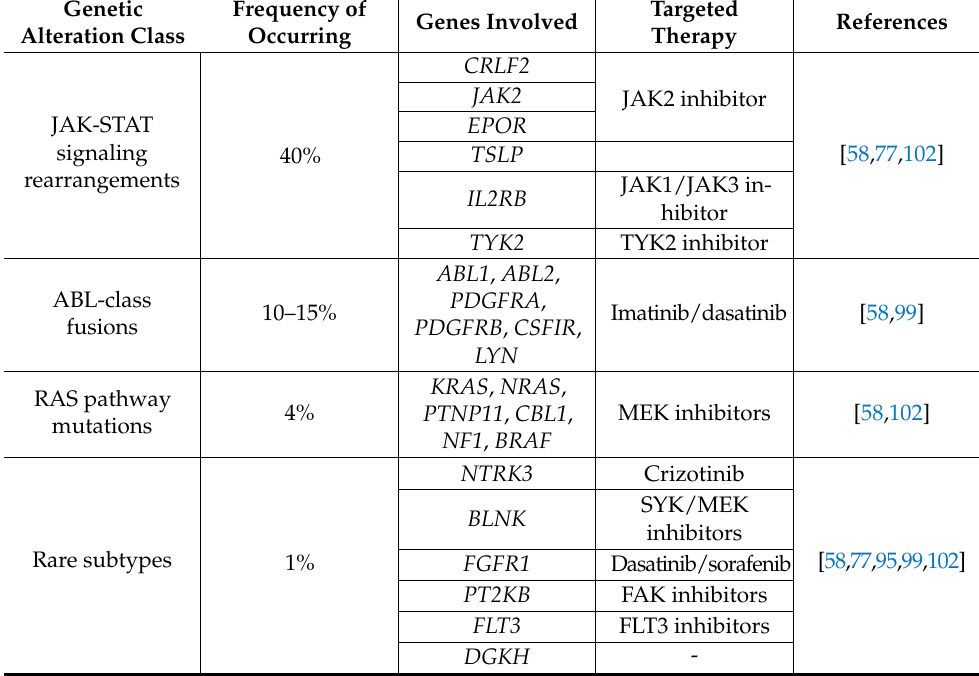
Table 1. The frequency and spectrum of genetic alterations in Ph-like